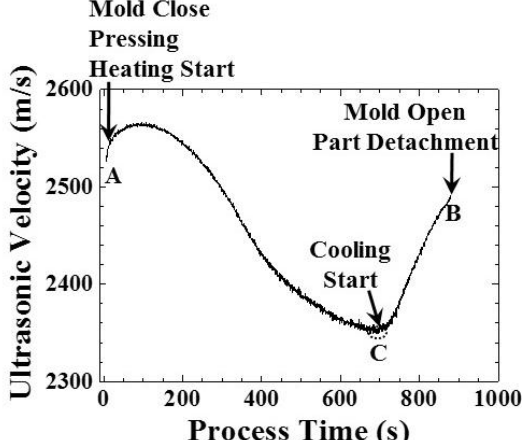
Figure 9. Variation of the ultrasonic velocity under the temperature setting of 100  C, indicating the mold closure, pressing, heating, cooling and mold opening during the embossing